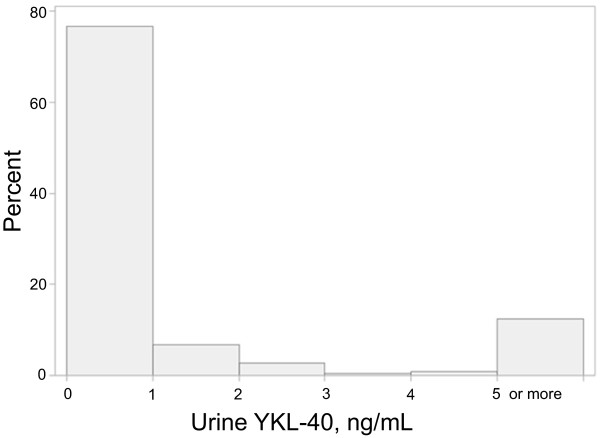
Distribution of urine YKL-40. YKL-40 ≥ 5 ng/ml was set at 5 ng/ml for this histogram. The 10th, 50th and 90th percentile values were 0.02, 0.2 and 13 ng/ml, respectively.